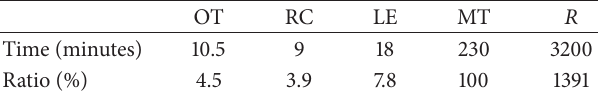
Table 3: Comparison of the soil area percentage values obtained by thresholding methods (Otsu (OT), Ridler-Calvard (RC), manual threshold (MT), and local entropy (LE)) with the reference area ( 𝐴 𝑅 ). The comparison was analyzed with a paired 2-tailed Student’s 𝑡 -test and a paired 2-tailed Wilcoxon nonparametric test in case of